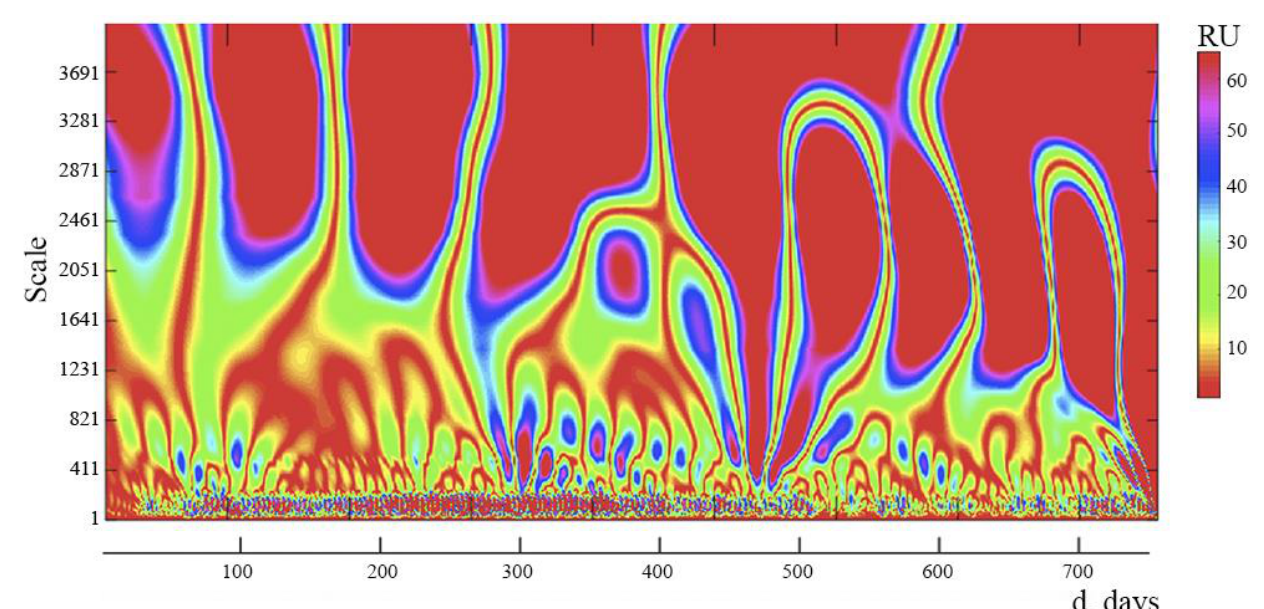
Figure 5. The wavelet spectrum of the daily number of new deaths from COVID-19 in Russia. The color scale determines the amplitude of the spectrum in relative units (RU).